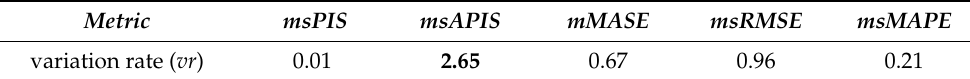
Table 2. Average variation rate of performance metrics for a variation in standard deviation and fixed bias of forecast